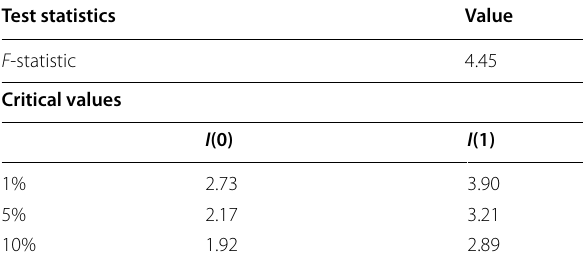
Table 3 ARDL bound test. Source: E-Views Output Test